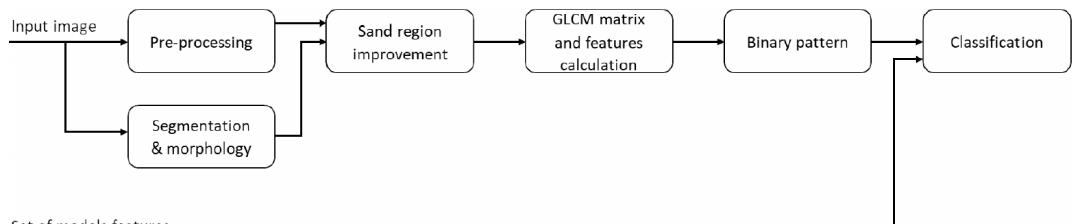
Figure 10. Scheme diagram of the proposed